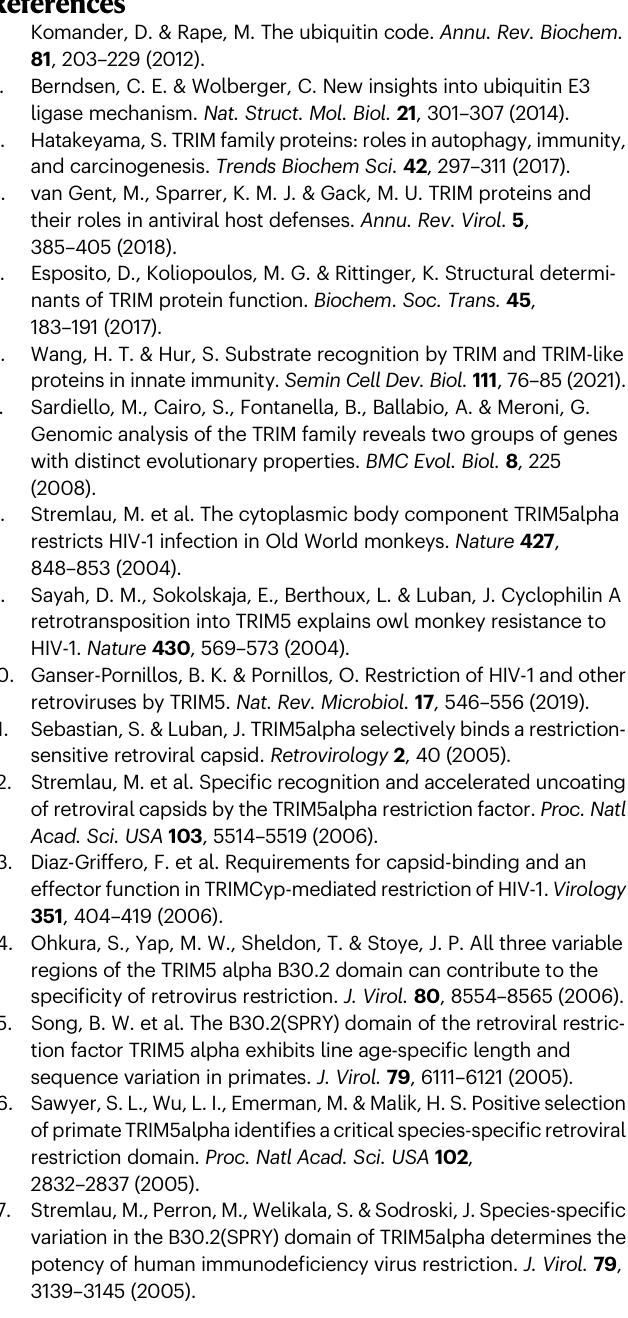
Fig. 2C. Puri fi ed FRET-active E2-Ub conjugates are now commercially available from E3 Bioscience LLC